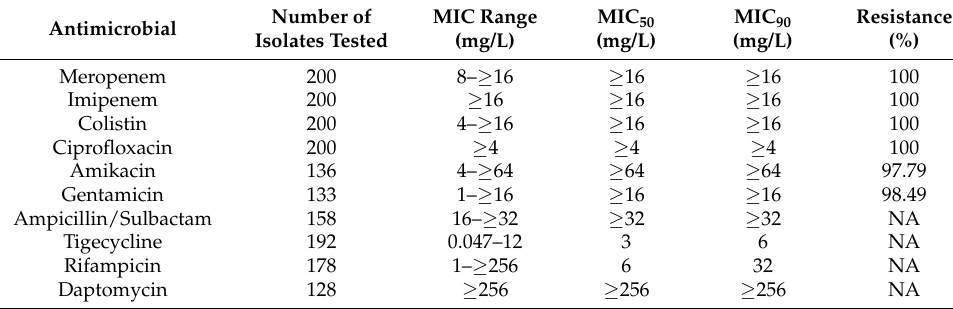
Table 1. Antimicrobial profile of A. baumannii isolates. NA: not applicable.